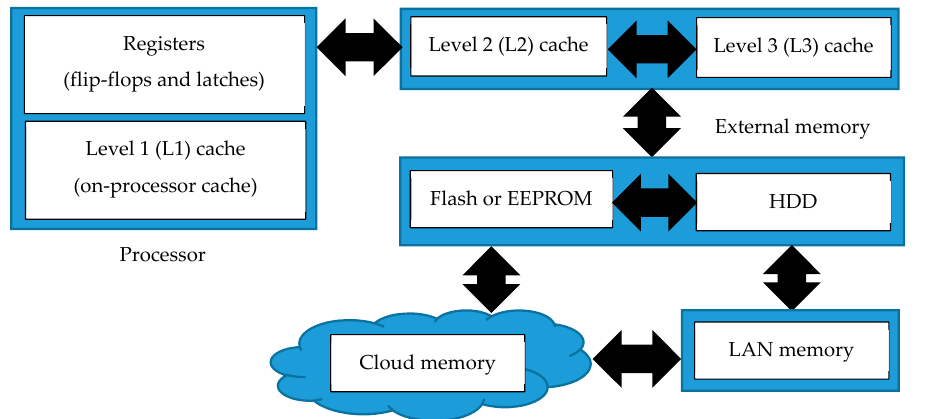
Figure 3. Availability of memory types in IoT applications.